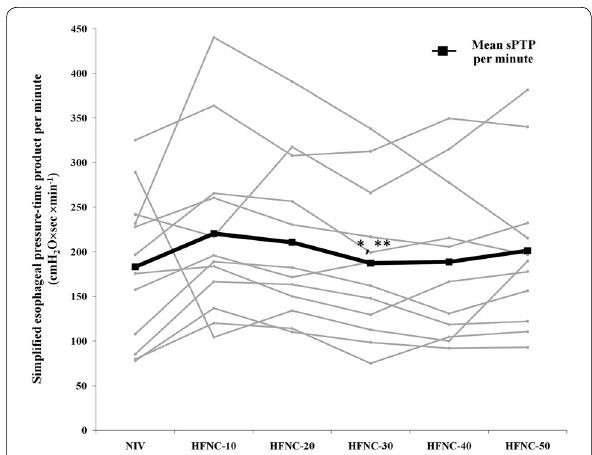
Fig. 2 Individual data and mean value of simplified esophageal pressure–time product (sPTP es ) per minute during non-invasive ventilation (NIV) and high-flow nasal cannula (HFNC) at different flow rates. *Indicates p < 0.05 in comparison to HFNC at a flow rate of 10 L/ min, **Indicates p < 0.05 in comparison to HFNC at a flow rate of 20 L/